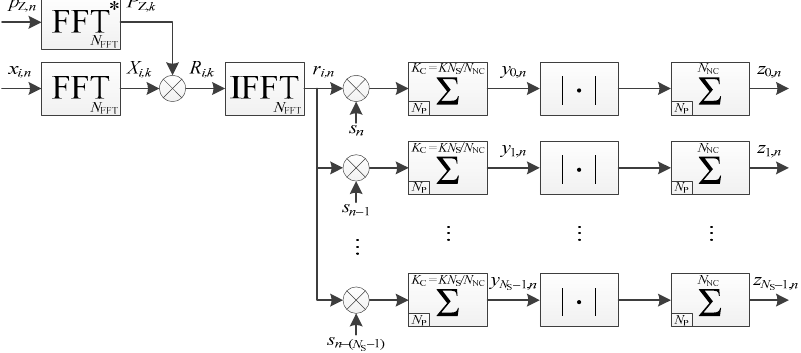
Figure 8. Implementation of a pilot channel acquisition, with non-coherent accumulation, in a parallel way (timing diagram available in Figure 5).